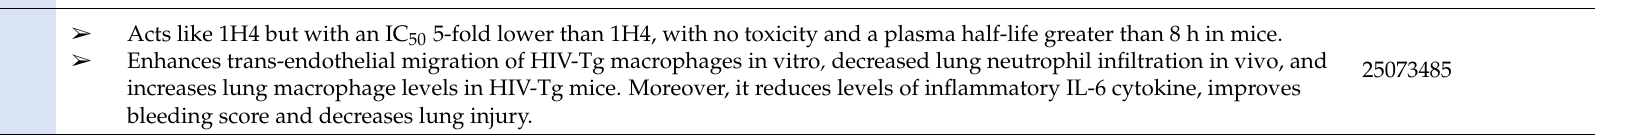
Prevents the translocation of PP1 to the nucleus.